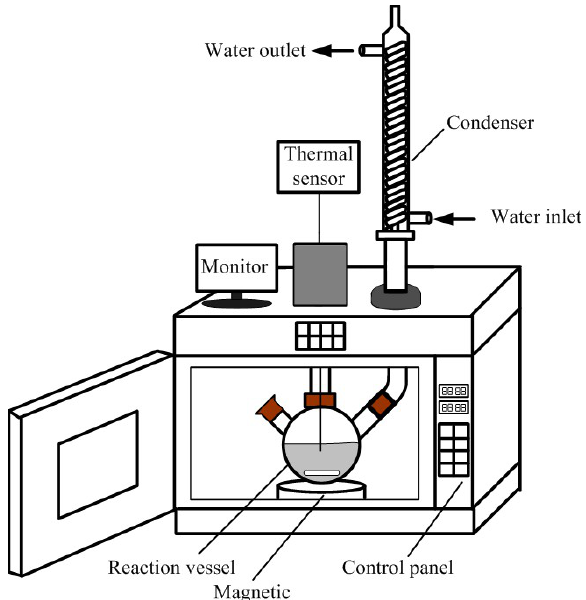
Figure 1. The experimental setup.